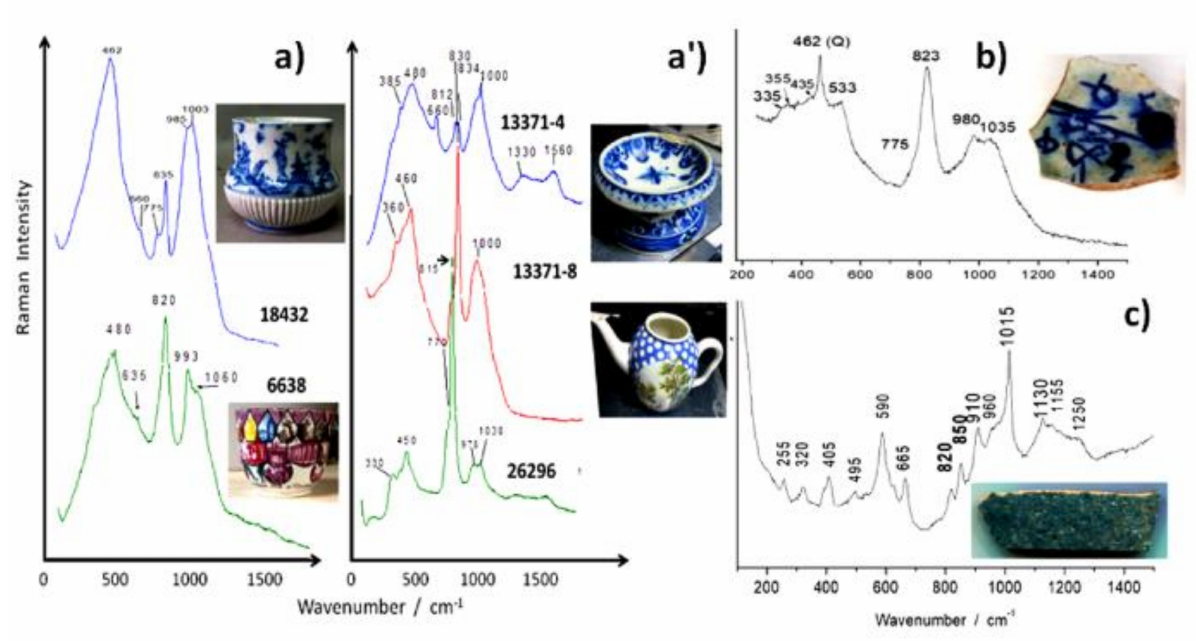
Figure 13. Similarity of the Raman signatures measured on blue glazes: French soft-paste porcelains, ( a ) 18432: ointment pot from Rouen Factory, end of the 17th-Century, 6638: pallet cup from the Vincennes Royal Factory made by Pierre-Antoine- Henry Taunay in 1748; ( a’ ) 13371 (different spots-4,8): salt container assigned to Dominique or Pierre Chicaneau or Marie Moreau, from the Saint-Cloud or Paris Factory, beginning of the 18th-Century and 26296: tea pot from the Vincennes Royal Factory, middle of the 18th-Century; note that different signatures of As-based phases can be observed on the same object, see [219]); ( b ) Raman spectrum of an arsenic-containing blue pigment recorded on a sherd unearthed at the ancient Iznik tile kilns (Co: 0.42; As: 0.31; Ni: 0.13; Cu: 0.98 wt.%), ( c ) similar Raman spectrum recorded on a blue speckled glazed sherd excavated at Qalhat site (The Sultanate of Oman) exhibiting spectra of Co-olivine and of margarosanite (Ca 2 PbSi 3 O 9